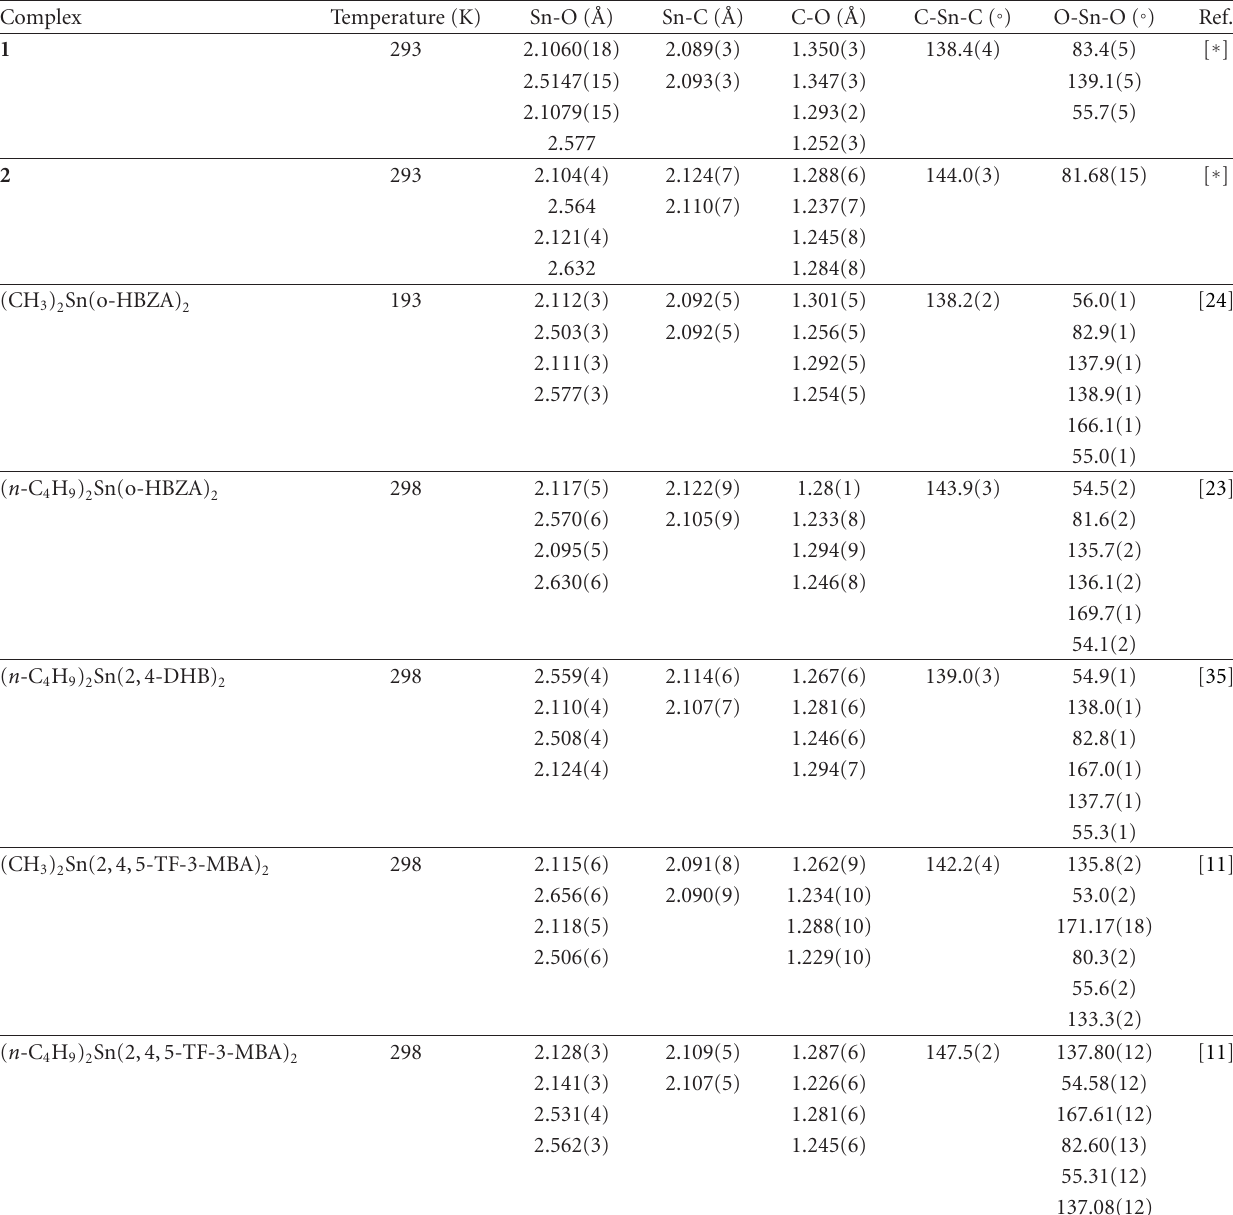
Table 3: Selected bond distances ( ˚A) and angles (deg) for the known diorganotin compounds with carboxylate ligands.